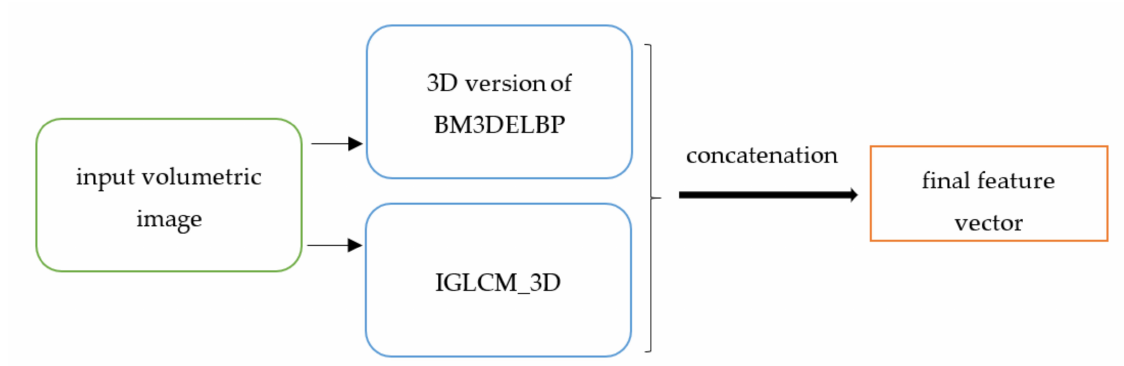
Figure 3. The block scheme of the proposed feature extraction technique.